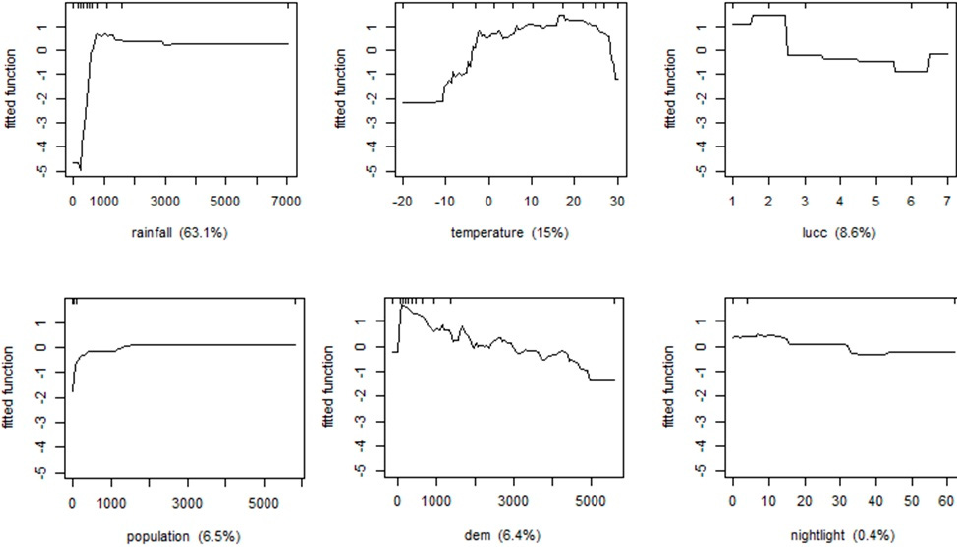
Figure 8. Boosted regression trees (BRT) model analysis of the relationship between NDVI and six factors. (Land cover types: 1. croplands; 2. forests; 3. grasslands; 4. wetlands; 5. urban areas; 6. unused land; 7. water bodies) .